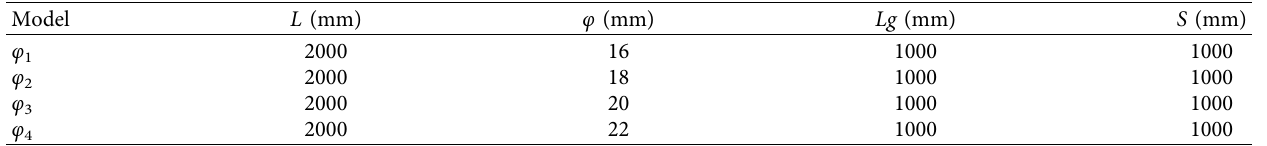
Table 7: Model design with different bolt diameters.